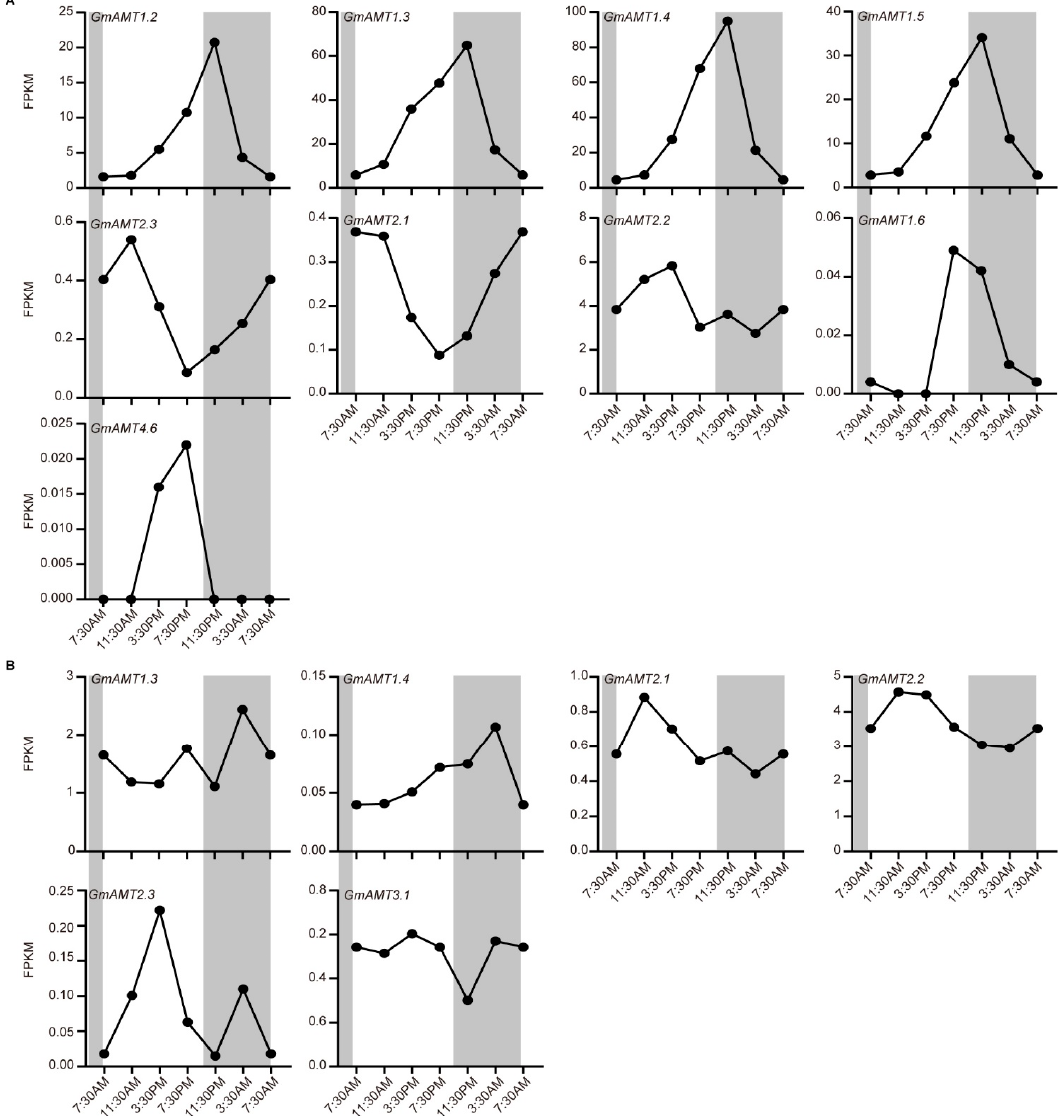
Figure 7. Day–night variations in gene expression of GmAMT family genes by RNA-seq data. The FPKM data of GmAMT genes were collected from the JGI Plant Gene Atlas [45]. The day–night expression patterns of GmAMTs in leaves ( A ) and nodules ( B ). Dark periods are highlighted as shaded columns.